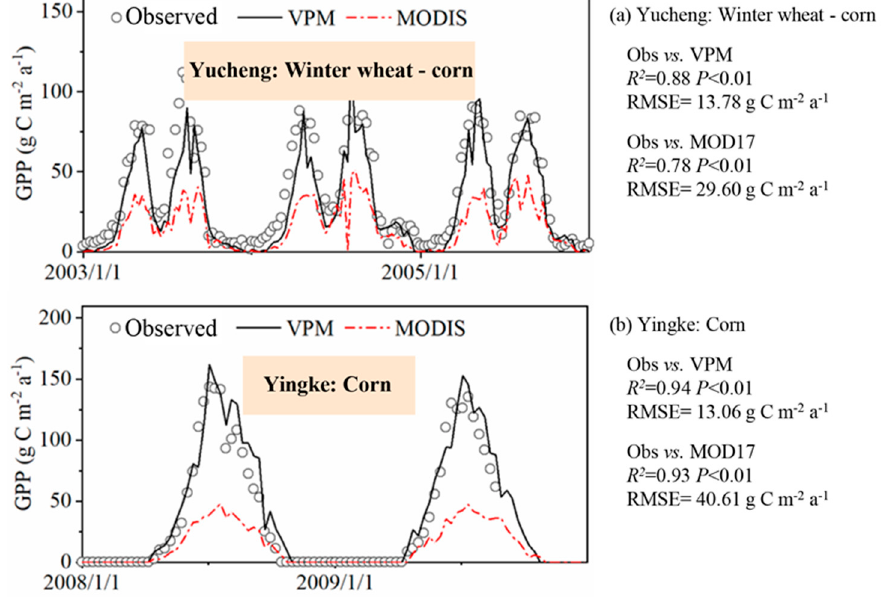
Figure 9. Relationship between simulation results of different GPP models and observed values (drawing refers to [33]).